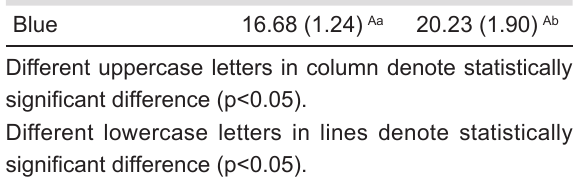
Different uppercase letters in column denote statistically significant difference (p<0.05). Different lowercase letters in lines denote statistically significant difference